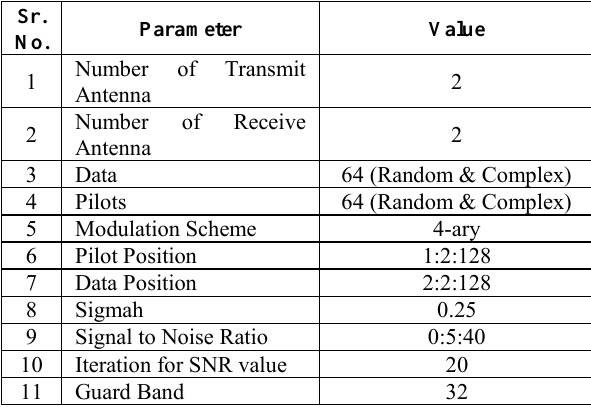
Table 1: Parameters for 2x2 MIMO systems